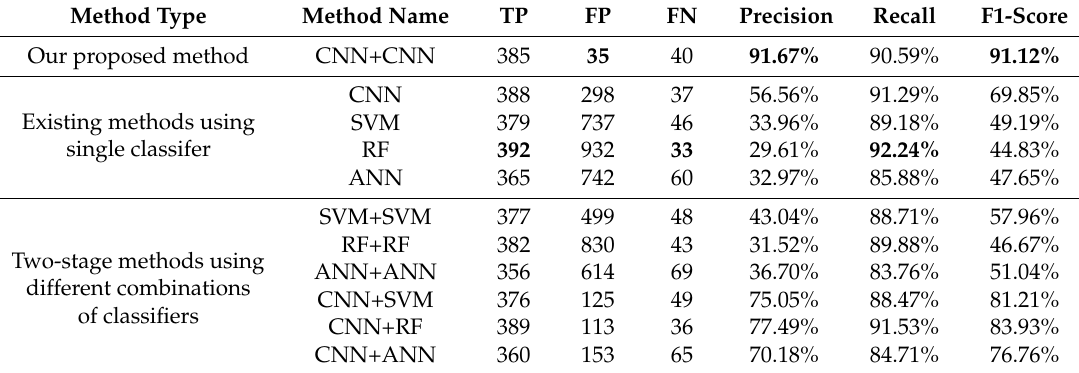
Table 7. The detection result of each method in Region 5.